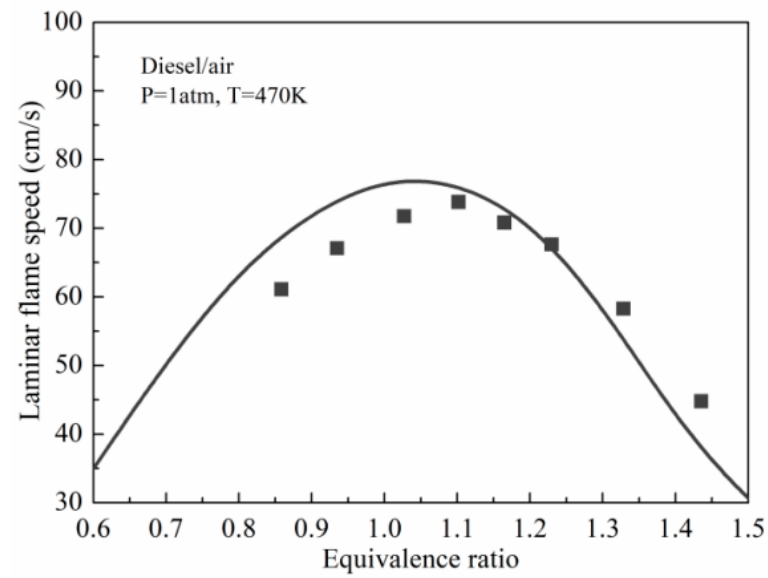
Figure 13. Measured (symbols) [37,38] and calculated (lines) laminar flame speeds of diesel/air mix- tures.